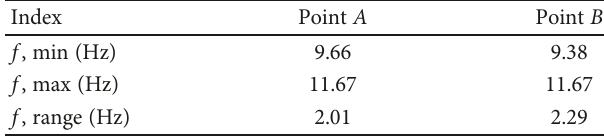
Table 9: D3, excitation far from the damage, localization